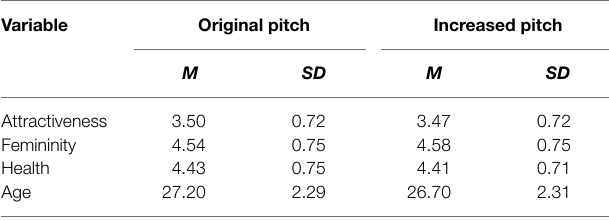
TABLE 3 | Means and standard deviations of face ratings with original and increased pitch. Variable